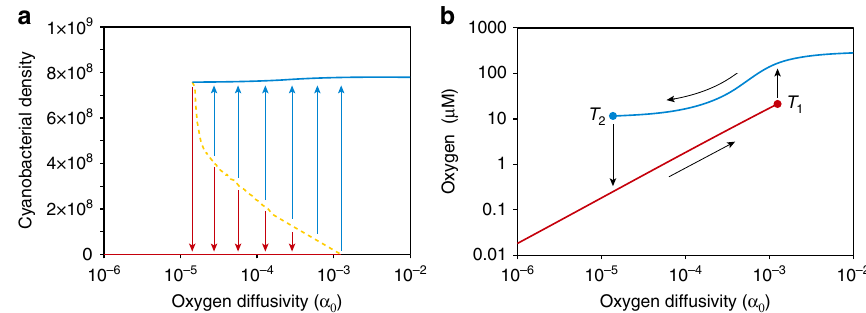
Fig. 3 Regime shifts between oxic and anoxic states. a Cyanobacterial population density and, b oxygen concentration predicted at steady state, as function of the oxygen diffusivity. Blue lines indicate the oxic state and red lines the anoxic state. In a the blue and red arrows indicate the basins of attraction of the oxic and anoxic state, respectively, and the dashed orange line is the separatrix between these two basins of attraction. In b T 1 and T 2 indicate the two tipping points of the system and black arrows illustrate the hysteresis loop. Parameter values are given in Supplementary Table 1, with P b = 9.5 μ M. The initial cyanobacterial density varies, while the other initial conditions are set at N PB = N SB = 1 × 10 8 cells L − 1 , S O = 250 μ M, S R = 350 μ M, O = 150 μ M, P = 9.5 μ M